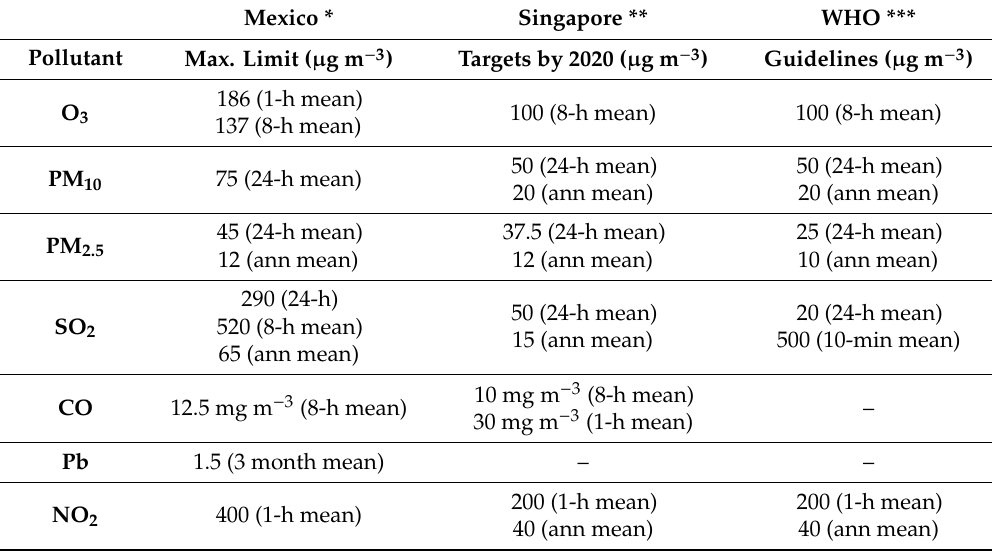
Table 1. Mexico’s ambient air quality standards, Singapore’s air quality targets, and WHO’s air quality